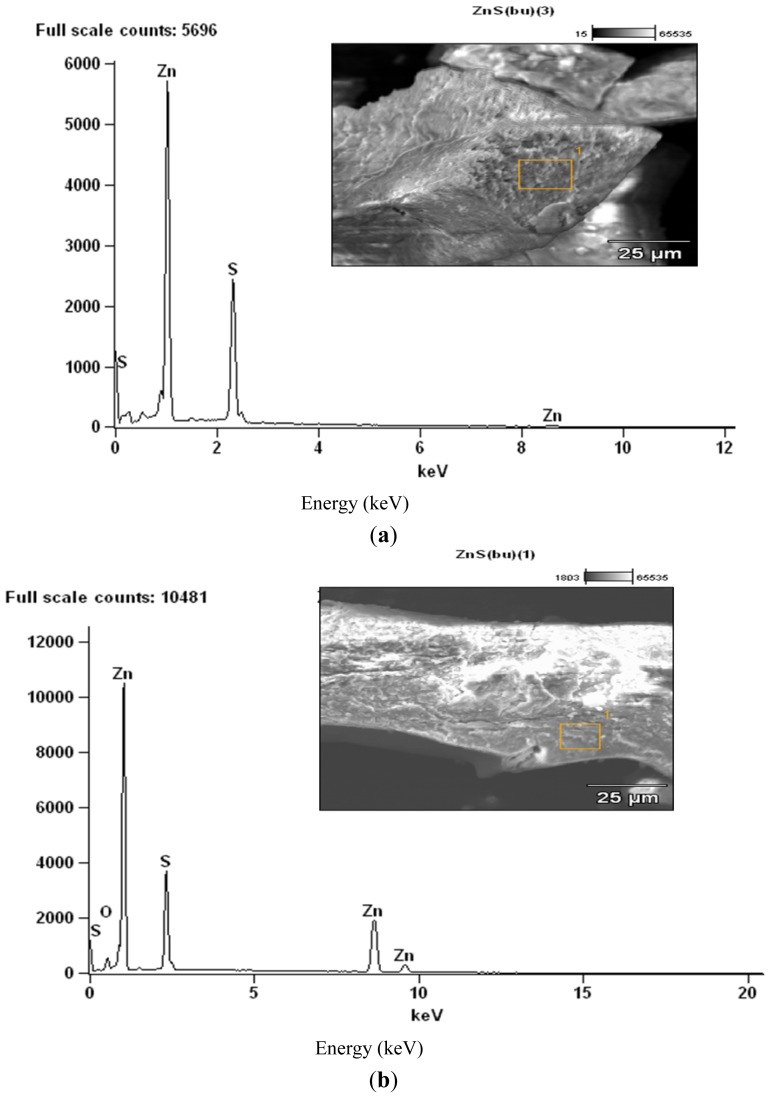
(a) Energy dispersive X-ray analysis (EDX) of the decomposed products from complex ZnL22 at 400 °C; (b) EDX of the decomposed products from complex ZnL22 at 800 °C.